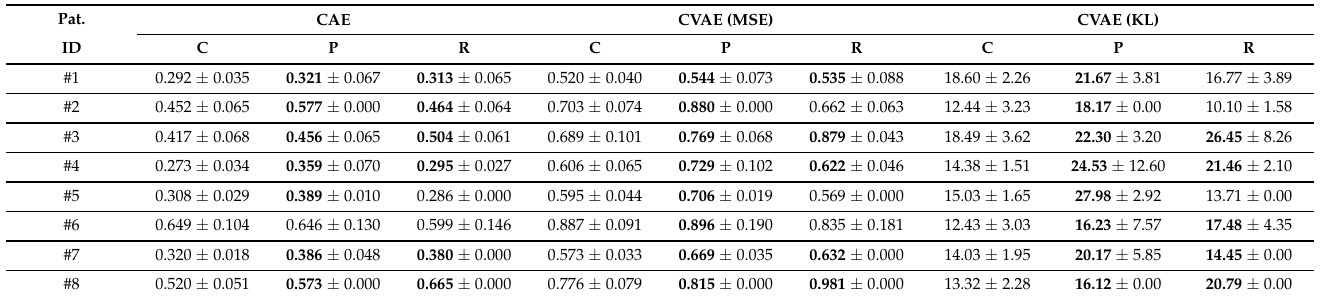
Table 11. Per-patient median anomaly scores for the discrimination between sessions that cor- respond to stable (C), pre-relapsing (P) or relapsing (R) condition, for both CVAE and CAE personalized models. 1